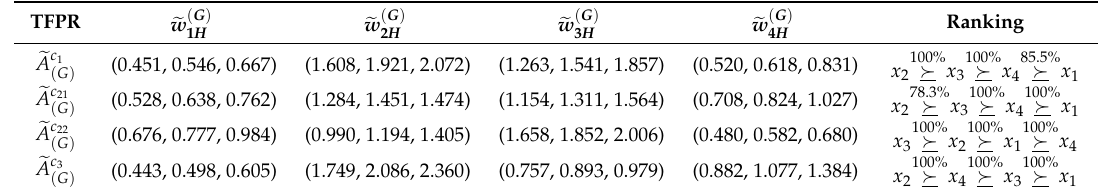
Table 7. Triangular fuzzy weights of group